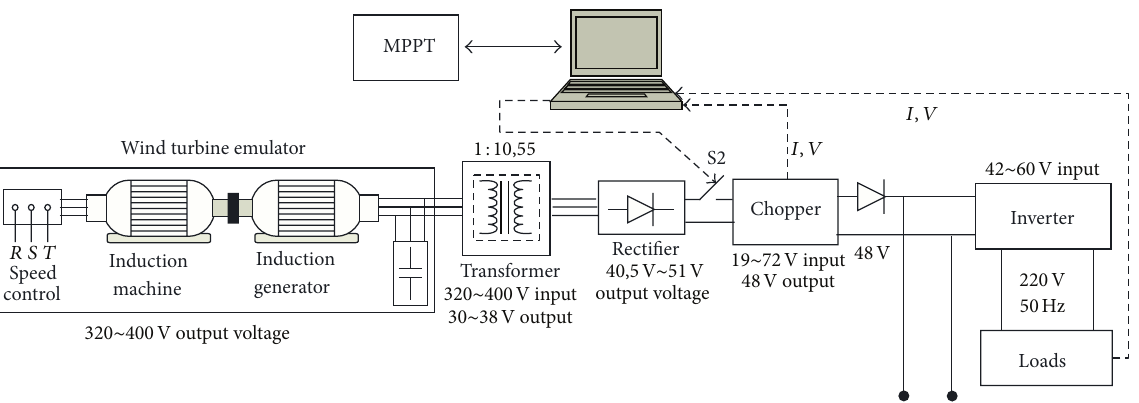
Figure 4: Feeding the loads with power generated from WES model.